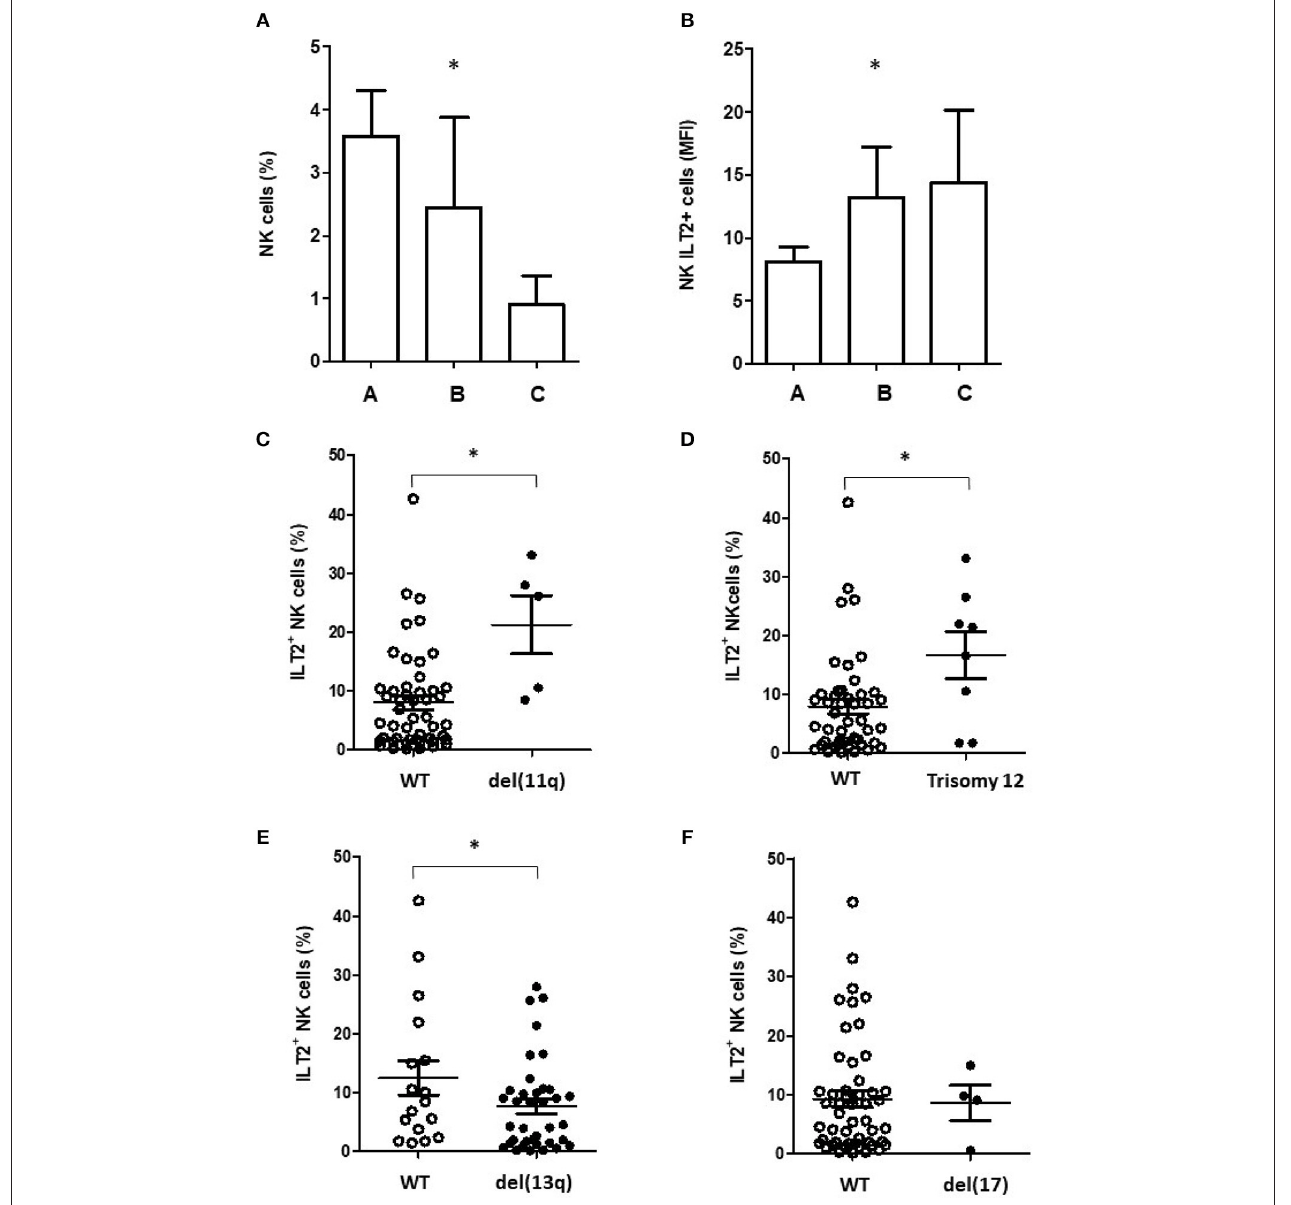
FIGURE 2 | ILT2 expression on NK cells associates with bad prognostic features of CLL patients. Histograms show the comparison of NK cells (A) and ILT2 + NK cells (B) percentages among CLL patients stratified by the Binet stage. Comparison of the percentage of ILT2 + NK cells in CLL patients stratified by the presence of chromosome del(11q) (C) , trisomy 12 (D) , del(13q) (E), and del(17) (F) . Horizontal bars represent the mean ± SEM. SEM, Standard Error of the Mean; Mann-Whitney U -test; * P < 0.05.